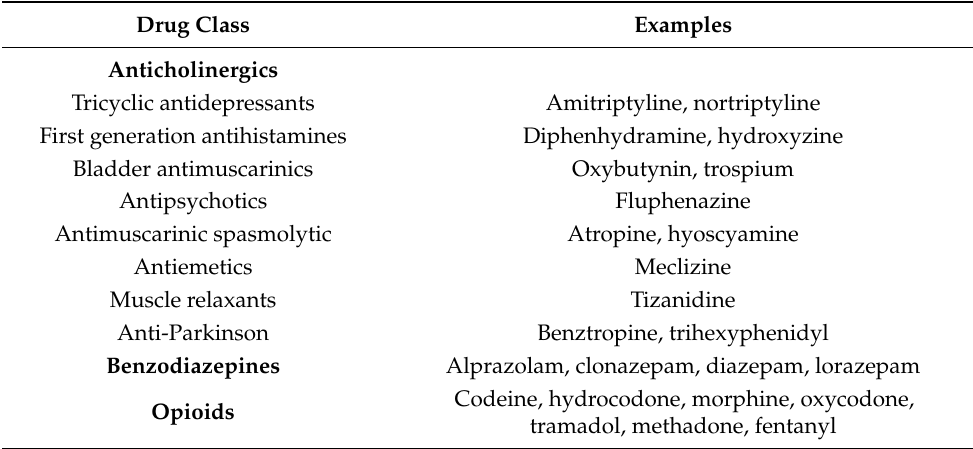
Table 3. Common medications associated with adverse cognitive